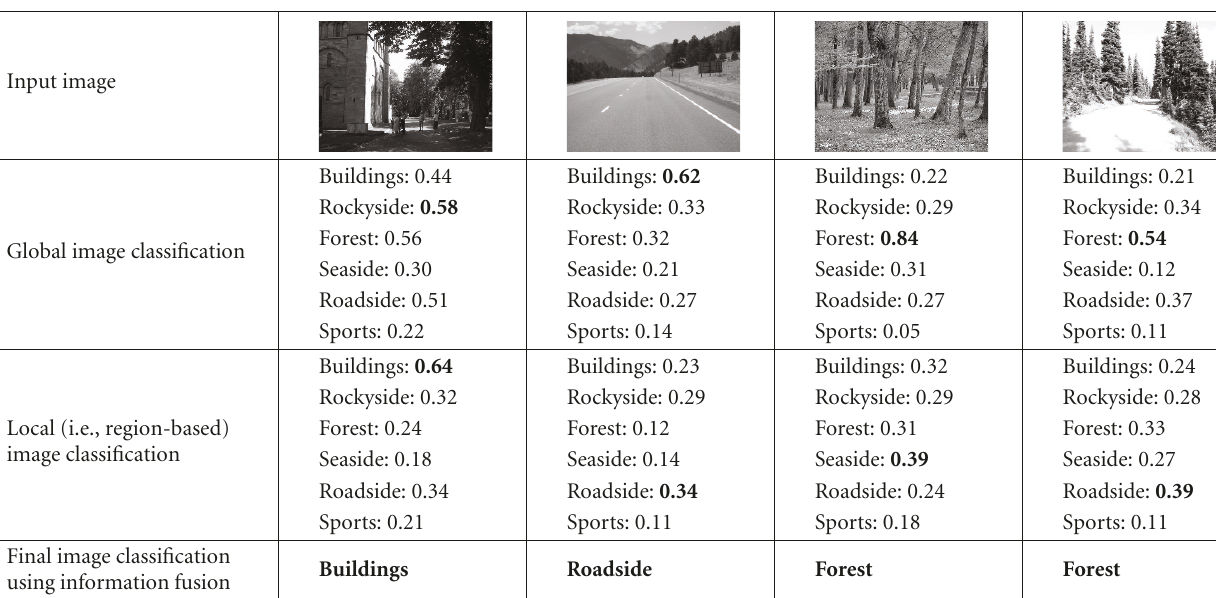
Figure 5: Indicative image-subdomain association